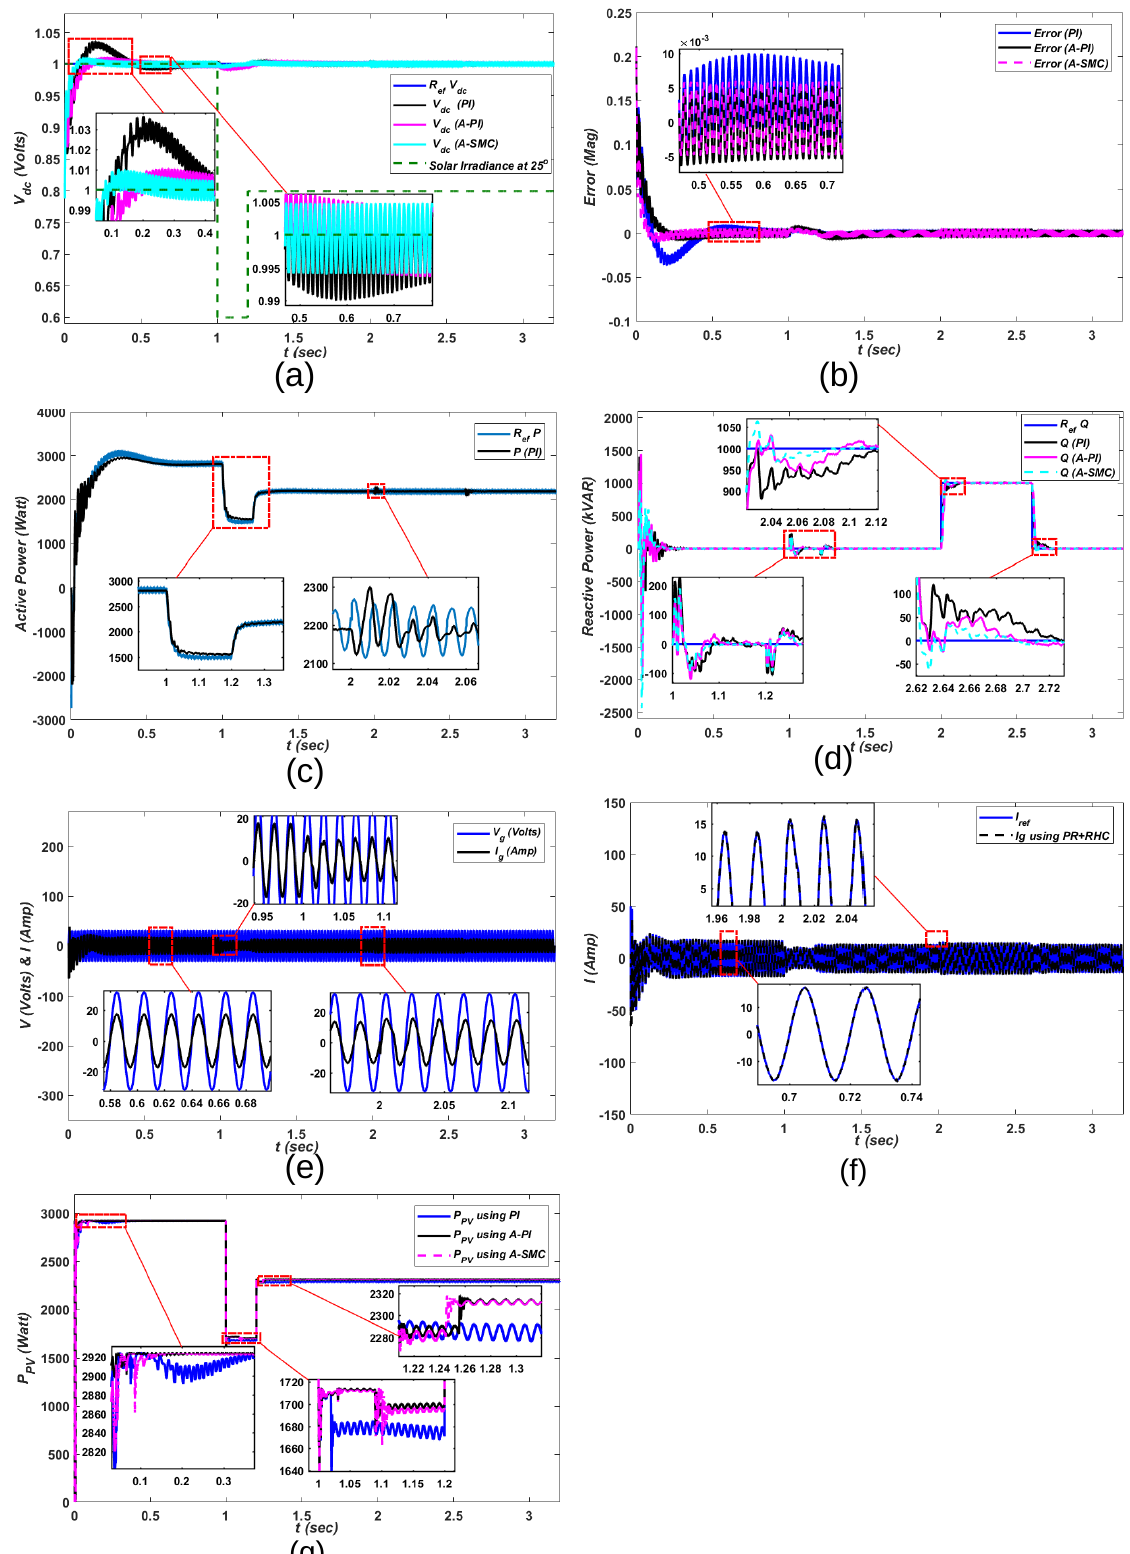
Figure 7. ( a ) The performance of DC-link voltage tested for the designed controllers; ( b ). Error response for PI, A-PI, and A-SMC. ( c ) Active power-loop response for PI controller. ( d ) Reactive power injection for designed controllers. ( e ) Grid voltage and current. ( f ) Grid currents using PR and RHC. ( g ) Power of PV panels for the designed